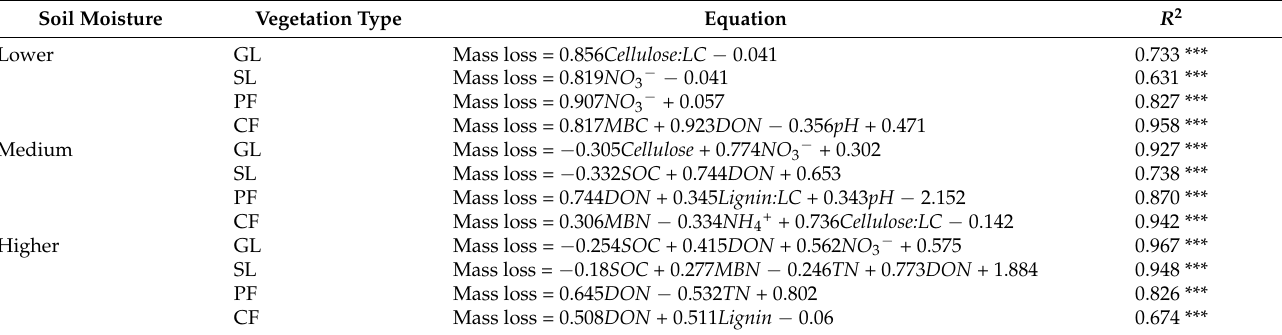
Table 4. Stepwise regression analysis of litter decomposition rate with litter and soil physico-chemical properties. Soil Moisture Vegetation